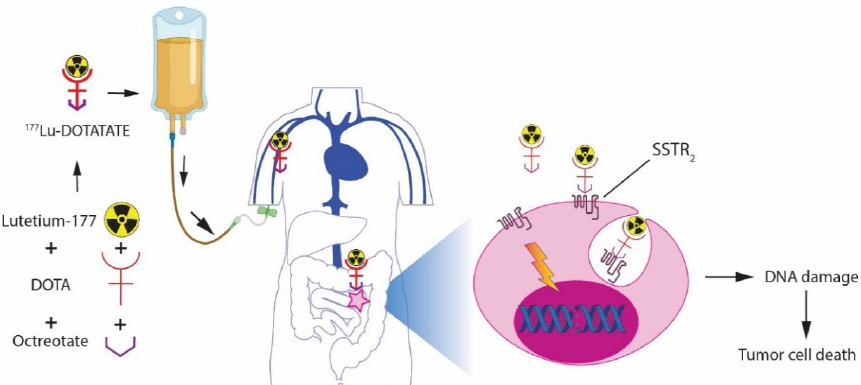
Figure 1. Mechanism of action of PRRT with 177 Lu-DOTATATE. Intravenous administration of 177 Lu-DOTATATE leads to tumor cell binding via SSTR 2 . After internalization of the radiopharmaceutical–SSTR 2 complex, local radiation by beta particles can lead to cell death through the induction of DNA damage (image created with BioRender.com, accessed on 1 September 2022).